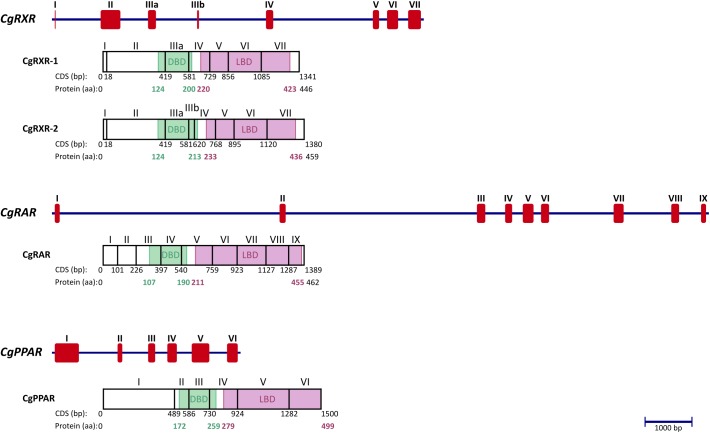
Exon/intron structure, coding sequence and protein organization of CgRXR-1, CgRXR-2, CgRAR and CgPPAR.Blue line: genomic sequence (bp); red rectangles: exons forming CDS (bp); roman numerals: number of exon; Arabic numbers: position and length for either CDS (bp) or protein (aa). Green boxes/numbers: DBD position in protein; purple boxes/numbers: LBD position in protein.